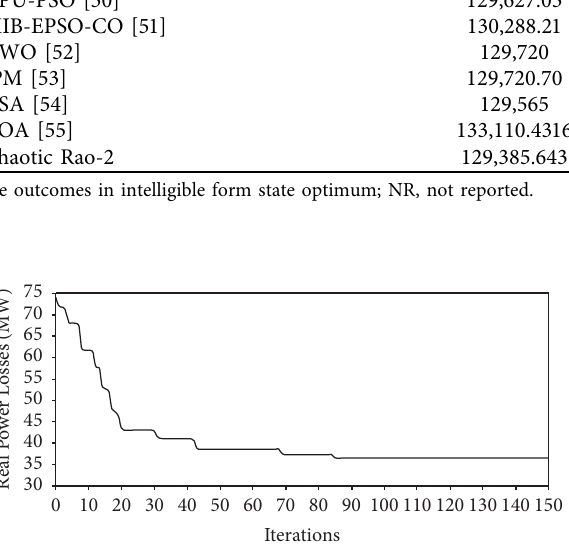
Figure 10: Convergence graph obtained for case 7 using the chaotic Rao-2 algorithm.